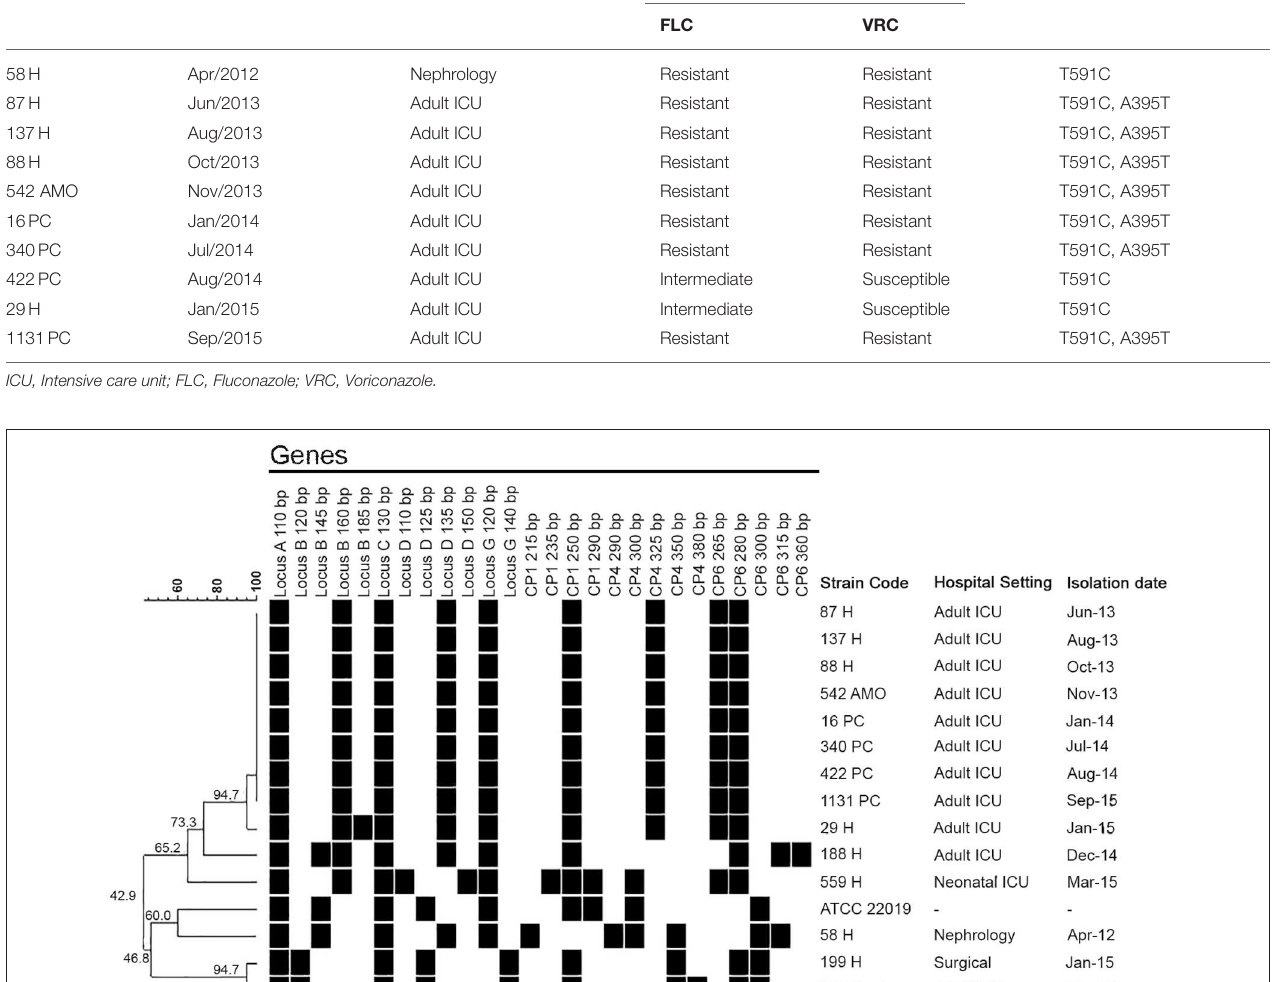
TABLE 2 | Susceptibility profile and ERG11 sequence analysis of the 10 Candida parapsilosis (sensu stricto) isolates non-susceptible to azoles. Isolates